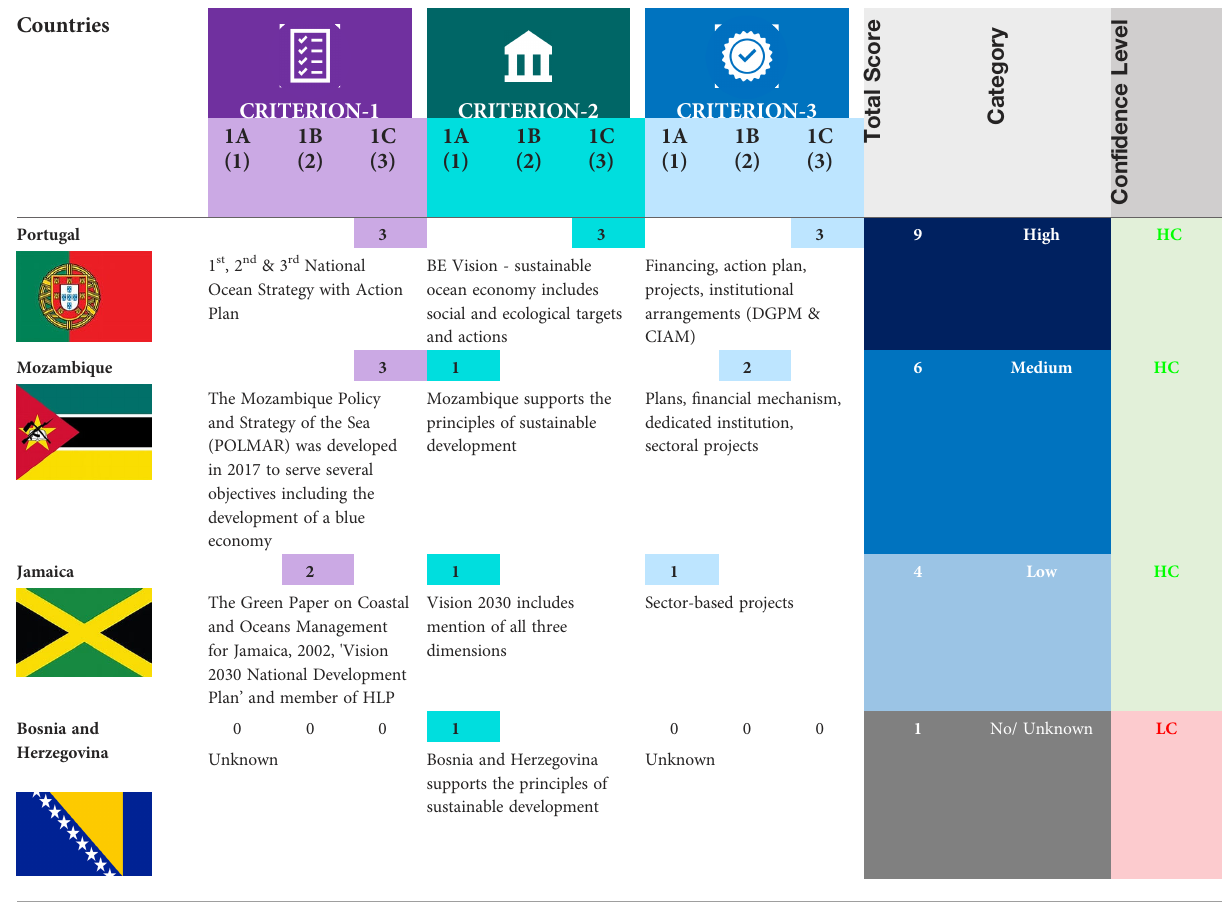
TABLE 1 Classi fi cation case studies in 4 sample countries. Countries